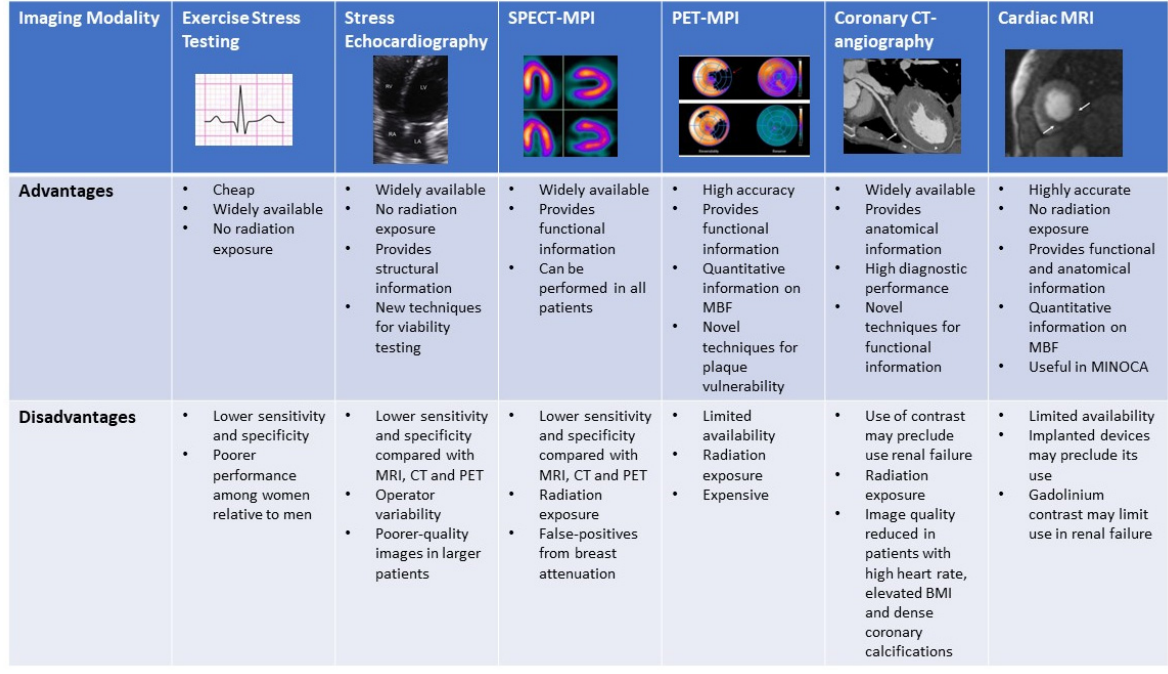
Figure 7. Figure comparing the advantages and disadvantages of the various non-invasive imaging